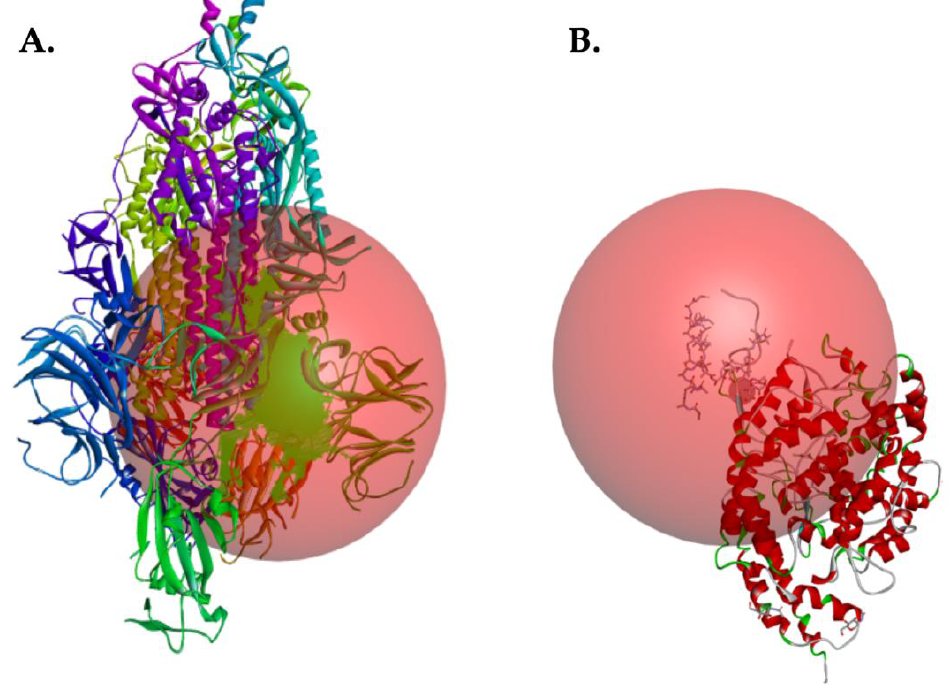
Figure 2. Binding sites of target proteins. Sgp (6VYB) ( A ) and host cell receptor ACE2 (1RL4) ( B ). Table 4. Interactions between AMPs and SARS-CoV-2 S Sgp. In green highest results. NA: Not applicable.